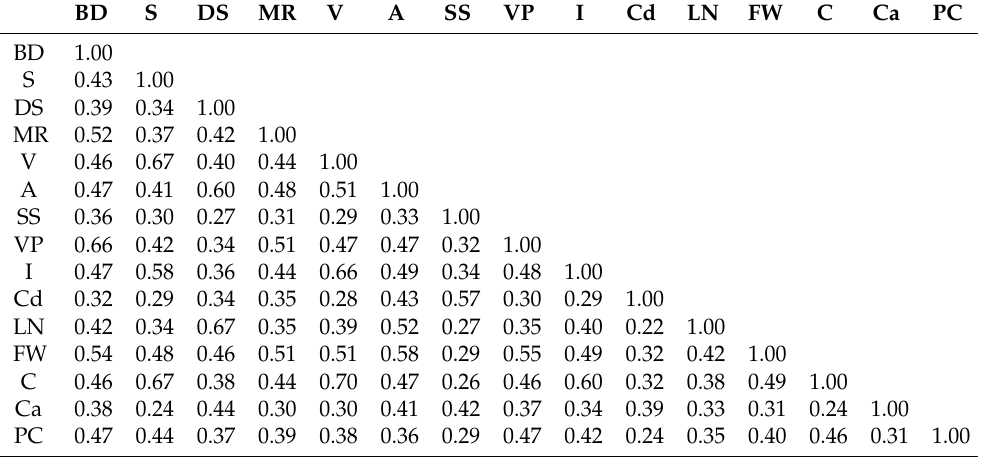
Table 1. Uncorrected correlation matrix provided by McFarland (2020): youngest group.